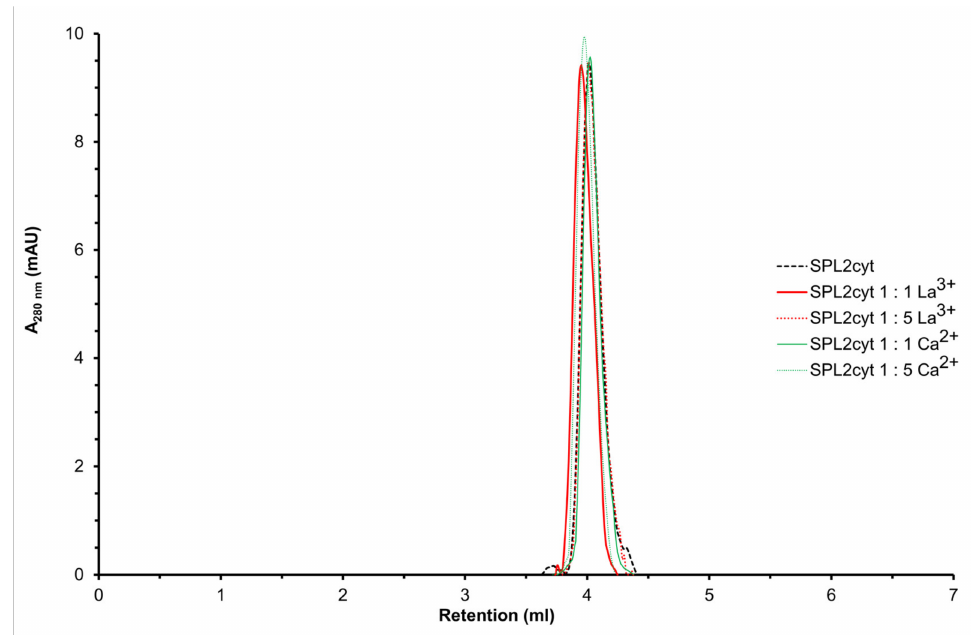
Figure A4. Analytical size-exclusion chromatography of SPL2cyt in the absence or presence of La 3+ or Ca 2+ at indicated molar